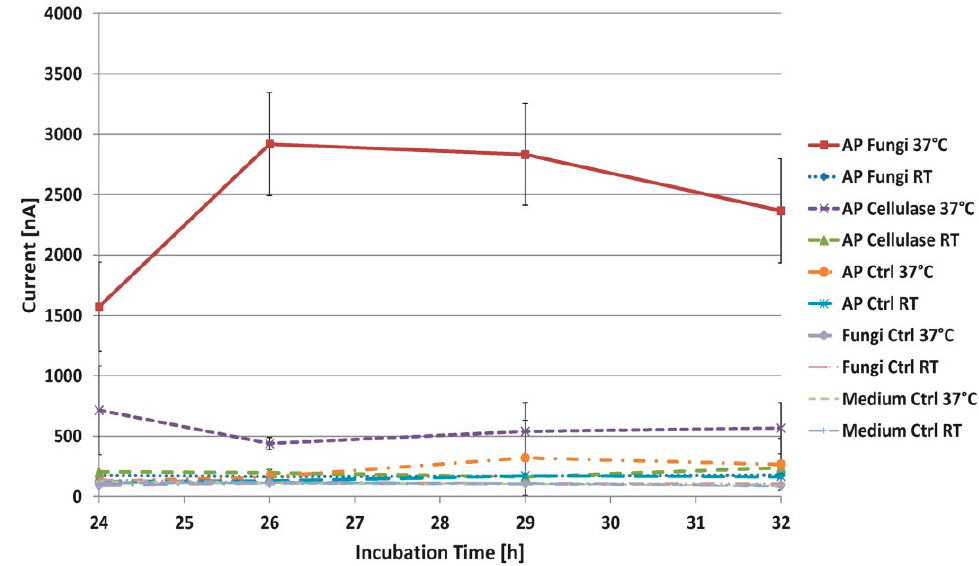
Figure 2. Investigation of the influence of temperature on the production of cellulase through the fungi (10 6 spores/mL) and on the activity of the enzyme (25 Units). The mean values of the current signal [nA] between 0–250 mV are shown for all samples over the total measurement time range (24– 32 h).